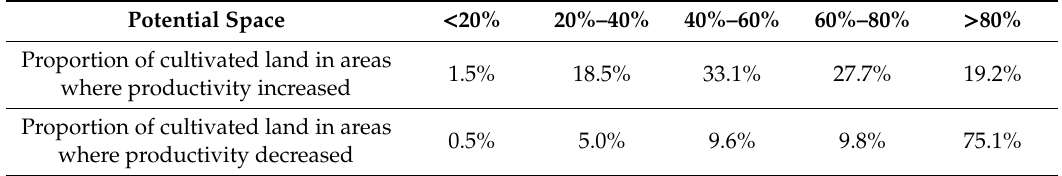
Table 6. Statistics of the potential space of the second crop in productivity changed areas. Potential Space < 20% Proportion of cultivated land in areas where productivity